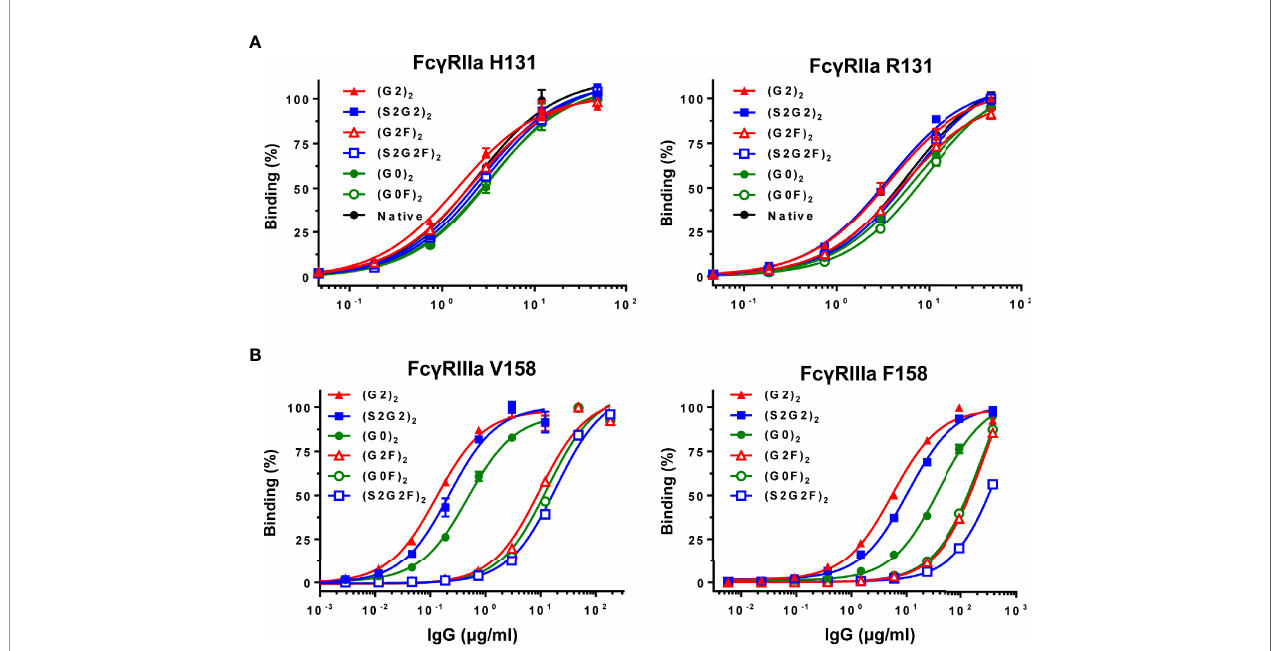
FIGURE 2 | Binding of IgG glycoforms to Fc g Rs. (A) Fc g RIIa H131 and R131 variants. (B) Fc g RIIIa V158 and F158 variants. All data points represent the calculated mean of two independent measurements from a total of at least two experiments. The data were fi tted to a sigmoidal dose-response curve (GraphPad Prism).